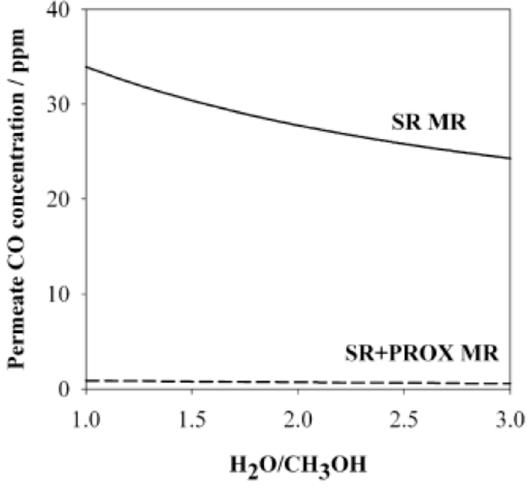
Figure 11. Simulation results of MSR reaction carried out in a MR and in a MR followed by a PROX reactor: Permeate CO concentration vs H 2 O/CH 3 OH feed molar ratio. With permission of reprint of Elsevier from Sà et al. [14].